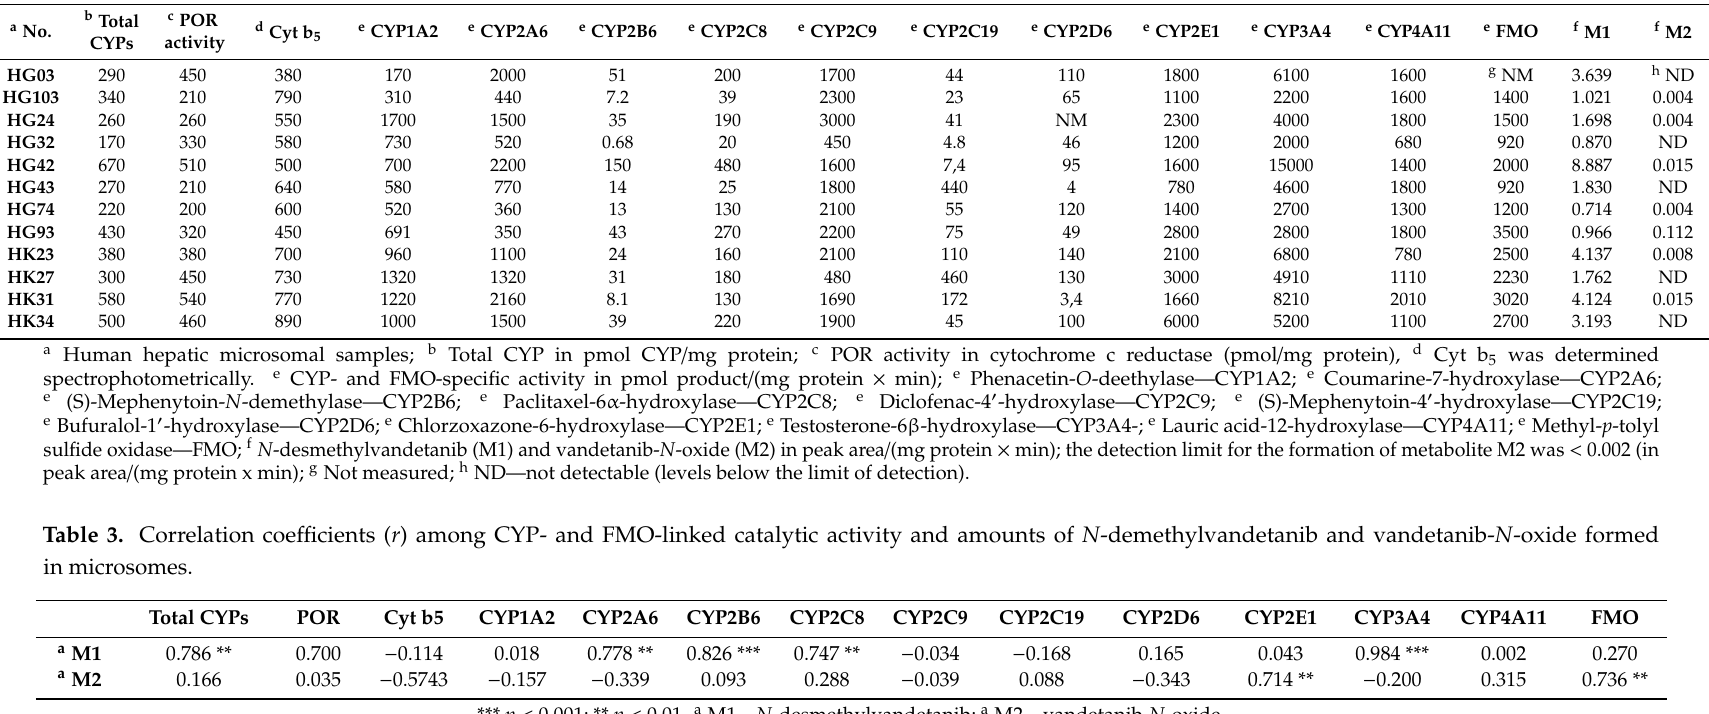
Table 2. CYP- and FMO-dependent catalytic activities and amounts of N -desmethylvandetanib and vandetanib- N -oxide in human liver microsomes.